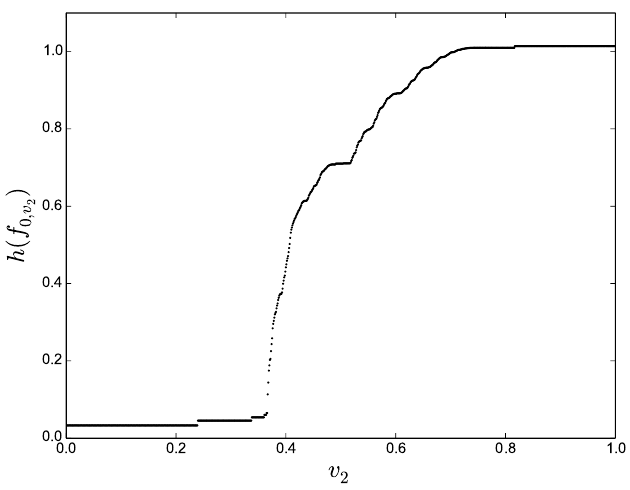
Fig. 3 Plot h ( f 0 , v ) in bits vs v 2 , 0 < v 2 ≤ 1 ( ε = 10 − 4 , ∆ v 2 = 0 . 001). 2